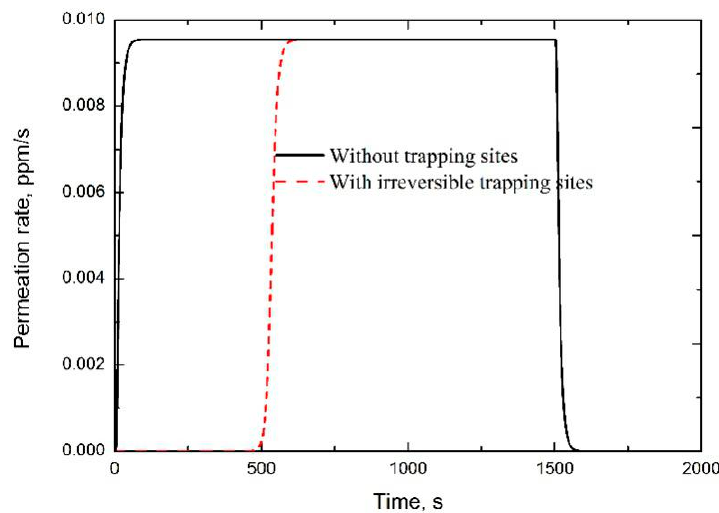
Figure 1. Influence of irreversible trapping sites on the permeation curve. An irreversible trapping site density of 4.89 × 10 25 m − 3 was assumed. Table 1. Input and examined parameters of simulated permeation curves considering irreversible trapping sites.